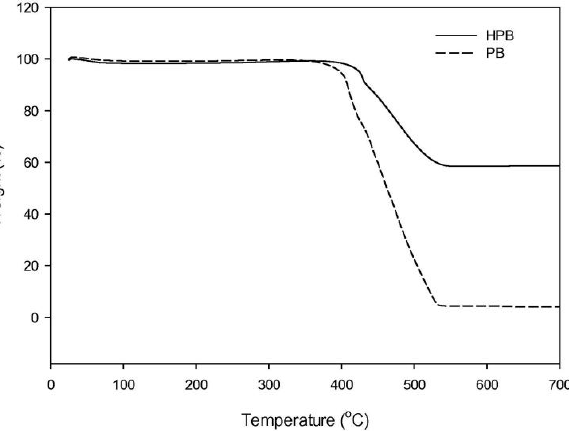
Figure 12. Thermogravimetric Analysis (TGA) of Pine Biochar (PB) and Hematite-Modified Biochar (HPB) [51]. Reprinted with permission from Shengsen Wang et al. (2014). Copyright 2014, Elsevier.